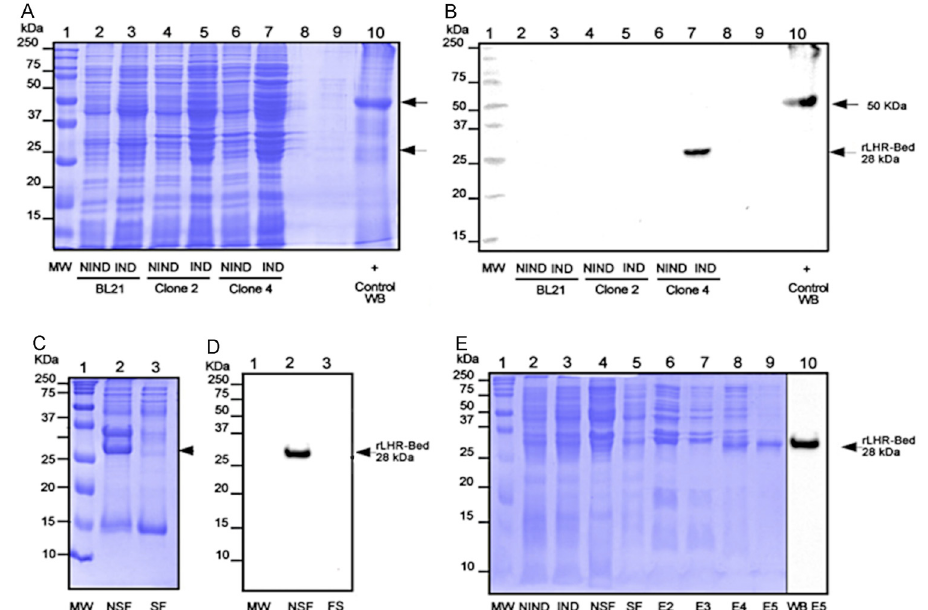
Figure 3. rLHR-Bed induction-solubilization-refolding-purification profile. ( A ) Lane 1 shows MW (molecular weight). Lanes 2–7 show non-induction (NIND) and induction (IND) for BL21 cells without transformation, Clone 2, and Clone 4, respectively. ( B ) Western blot (WB) SDS-PAGE shows rLHR-Bed profiles with detection signals between 25 and 37 kDa; this expression coincides clearly with rLHR-Bed (lane 7). The WB control was a 50 kDa protein with tag histidines (lane 10). Arrows indicate 50 and 28 kDa, respectively. ( C ) Solubility profile test of rLHR-Bed shows: MW (lane 1), non-soluble fraction (NSF) protein, (lane 2), and soluble fraction (SF) protein (lane 3). The arrow indicates rLHR-Bed. ( D ) Western Blot from a gel SDS-PAGE of the rLHR-Bed solubility profile. Lane 1 shows MW; lines 2 and 3 show NSF, and SF, respectively. The presence of rLHR-Bed can be observed in the non-soluble fraction at 28 kDa (lane 2). ( E ) Complete profile of rLHR-Bed purification and its WB detection. Lane 1 shows MW; lanes 2 and 3 show samples of NIND and IND, respectively; lines 4 and 5 show NSF and SF, respectively, lines 6–9 represent elutions 2–5. and 5; lane 10 shows the WB of elution